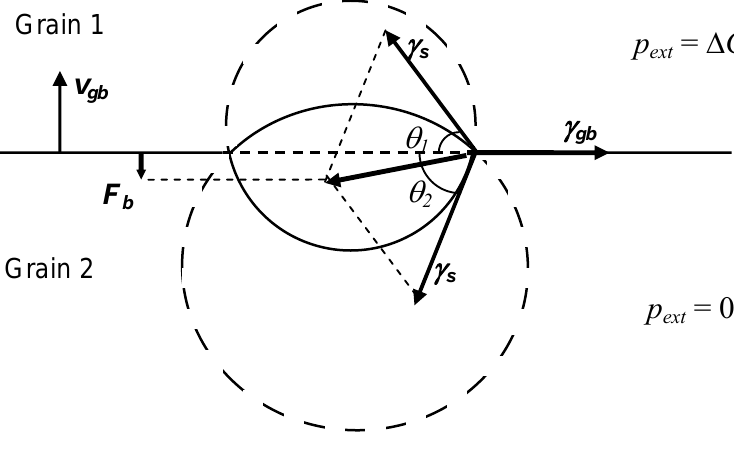
Figure 2. Determination of the drag force exerted by attached lenticular bubble on moving grain